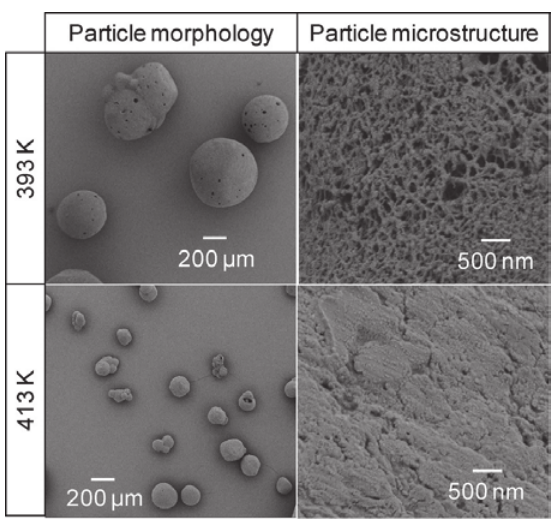
Fig. 8 Effect of gelatinization temperature on the par- ticle morphology and microstructure of starch aerogels 109) .